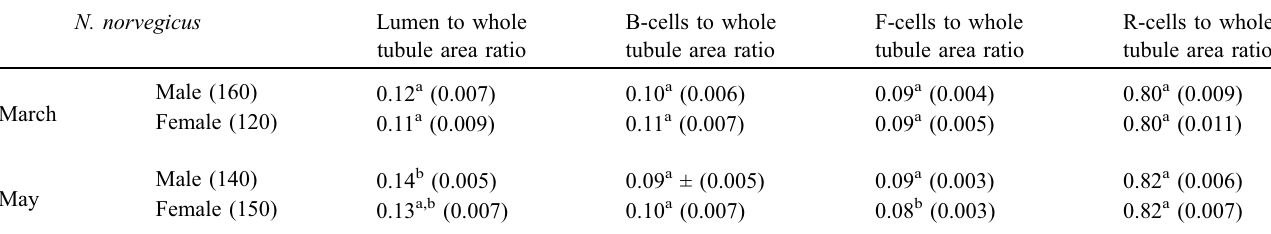
Table 2. Digestive gland ratios of structural elements of N. norvegicus compared between months and sex, with number of the measured tubules in brackets. Results are given as means with standard error of mean within parenthesis. Means in a column per month and per sex followed by the same superscript are not signi fi cantly different ( p > 0.05).